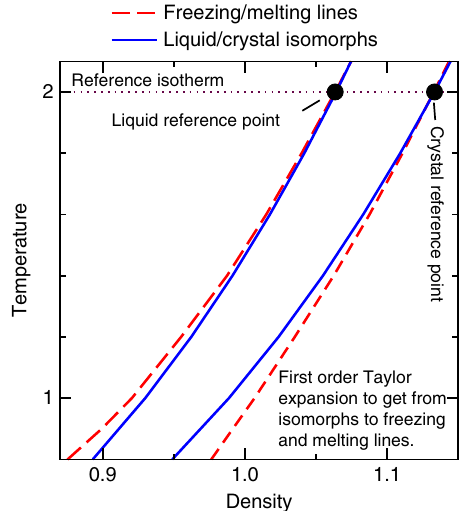
Figure 2 | Illustration of the main idea of the theory. The freezing and melting lines are both close to isomorphs along which basically everything is known because the reduced-unit structure and dynamics are invariant to a very good approximation. Properties along the freezing and melting lines are estimated via first-order Taylor expansions by moving from an isomorph to the freezing or melting line; the two reference isomorphs (a liquid and a solid one) are determined from computer simulations at T 0 ¼ 2.0 e / k B . Details are given in the ‘Methods’